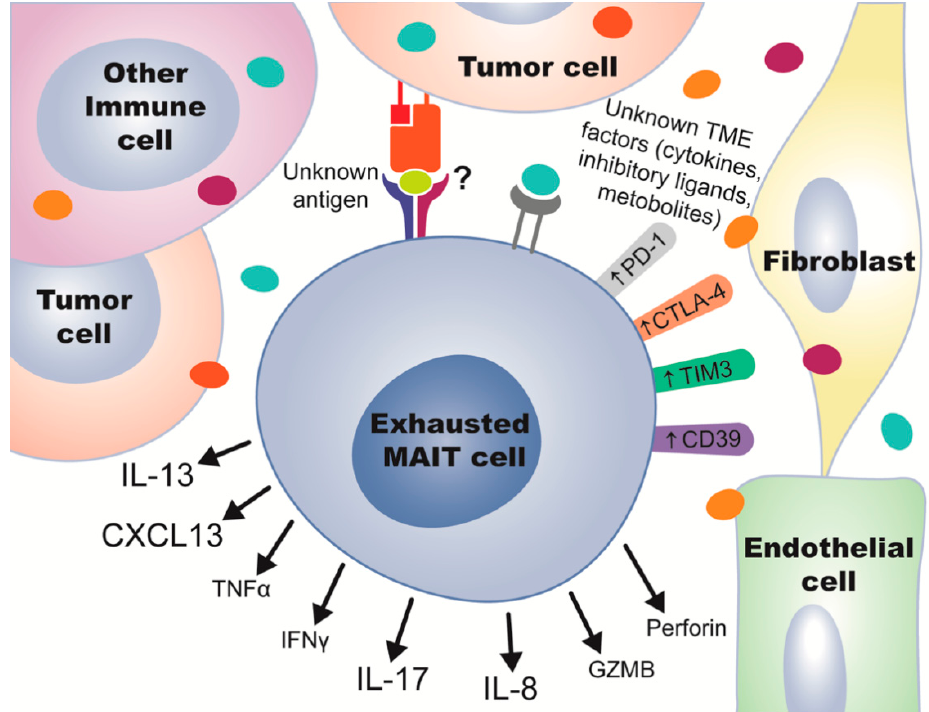
Figure 3. A TME-infiltrating and exhausted MAIT cell under various possible stimuli. The MAIT TCR is engaged by an unknown antigen from the TME, and other receptors are bound by unknown TME factors (possibly cytokines, inhibitory ligands, or other metabolites). Factors are potentially released by cells present in the TME such as tumor cells, fibroblasts, endothelial cells, or other immune cells. Effects from TME stimuli include upregulation of molecules PD-1, CD39, CTLA4, and TIM3, and well as release of cytokines IL-13, CXCL13, IL-17 and IL-8, with decreases in secretion of TNF- α , IFN- γ , GZMB, and perforin. The size of the text reflects the relative secretion of each molecule, whereas bigger text indicates more secretion and smaller text is less secretion.